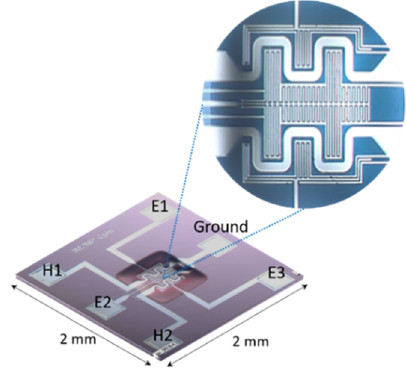
Figure 1 . Photographs of the MEMS ‐ based microsensor platform. Figure 1. Photographs of the MEMS-based microsensor